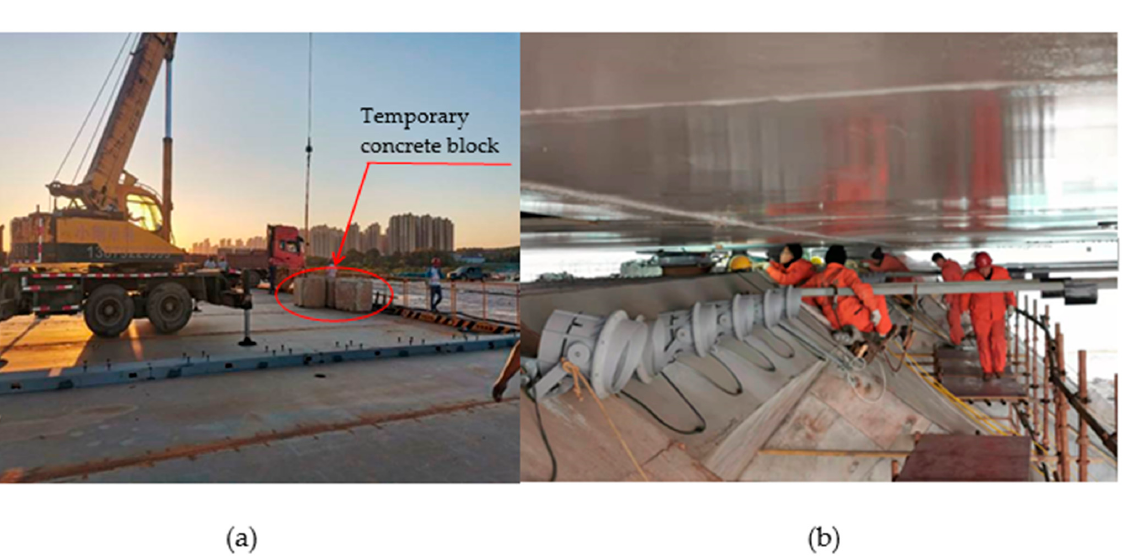
Figure 30. Theoretical deformation of the temperature gradient in the China standard (JTGD60-2015) (unit: mm).